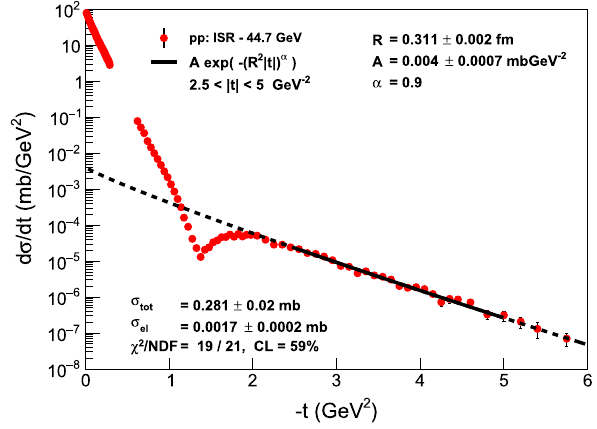
Fig. 31 Zeroth-order Lévy fits to the tail of the differential cross- section data on pp elastic scattering at fixed α = 0 . 9, A and R as free fit parameters